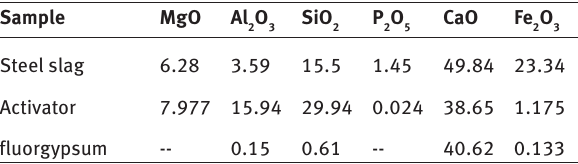
Table 1: Chemical and physical characteristics of the raw materials. (a) Chemical composition of binder materials (wt.